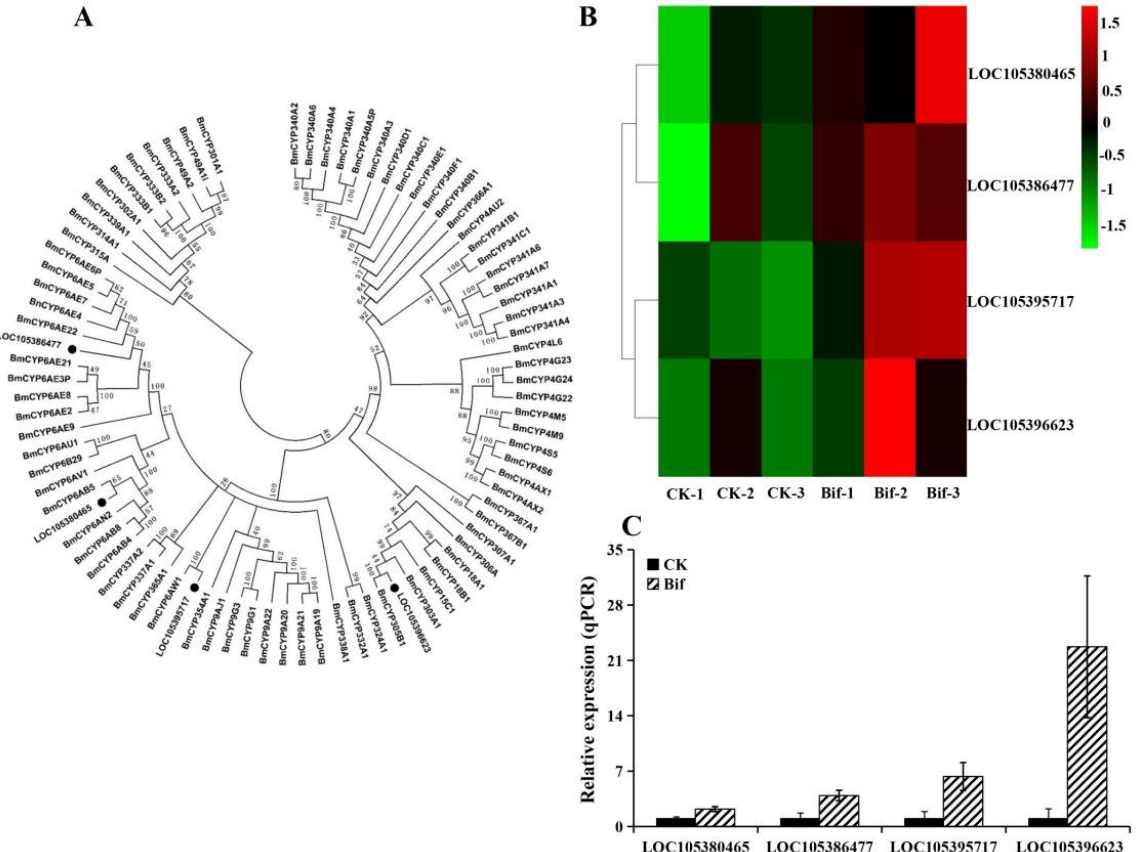
Figure 4. ( A ) Phylogenetic relationships of P450s from Plutella xylostella (black circle) and Bombyx mori . ( B ) Expression profiles (FPKM value) of four P450s in P. xylostella . X -axis: sample name, Y -axis: P450s. The colors indicated the expression levels of P450s, and red indicated high expression and green indicated low expression. ( C ) Expression profiles of four P450s in P. xylostella by qRT-PCR.